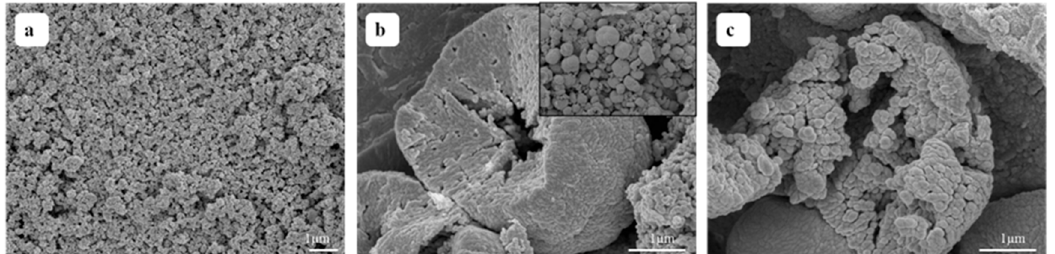
Figure 2. SEM images of the samples ZnO-0 ( a ); -2 ( b ) and -4 ( c ).